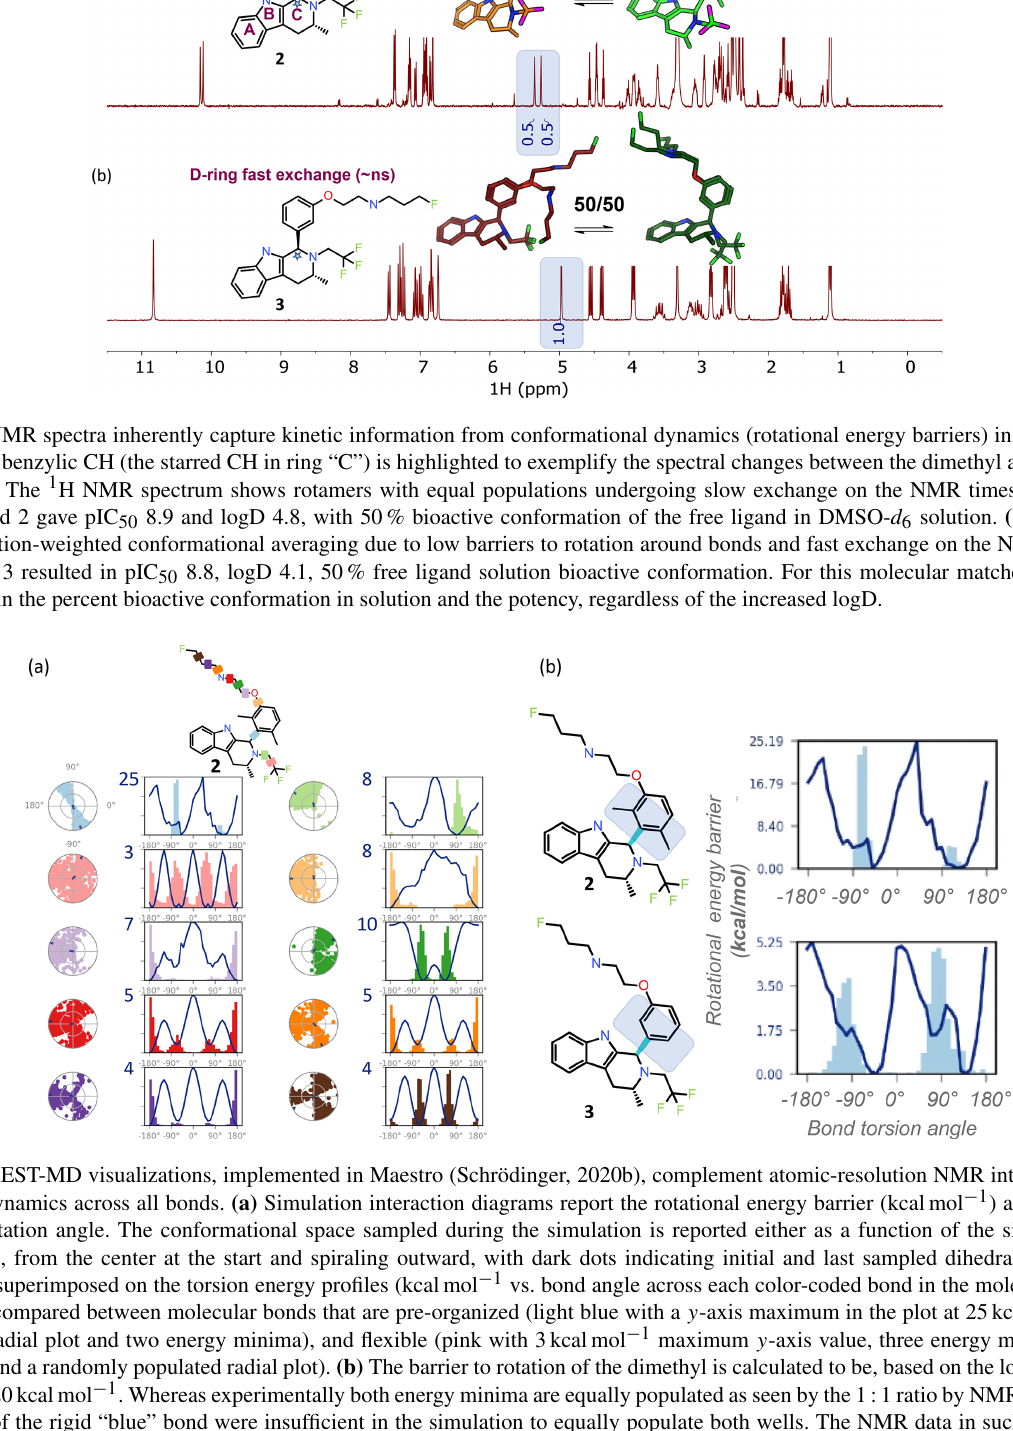
Magn. Reson., 2, 489–498,